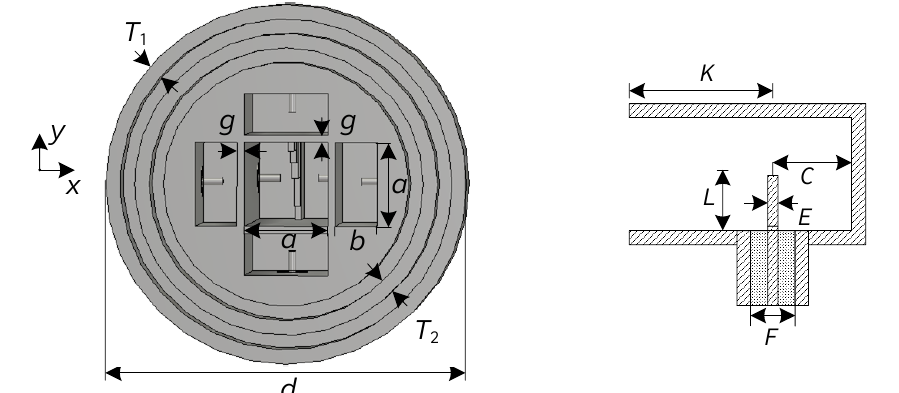
Figure 5. Dimensional parameters of the designed feed and the coaxial probe for the difference channel waveguide. Table 2. Dimensions (mm) of the designed feed.